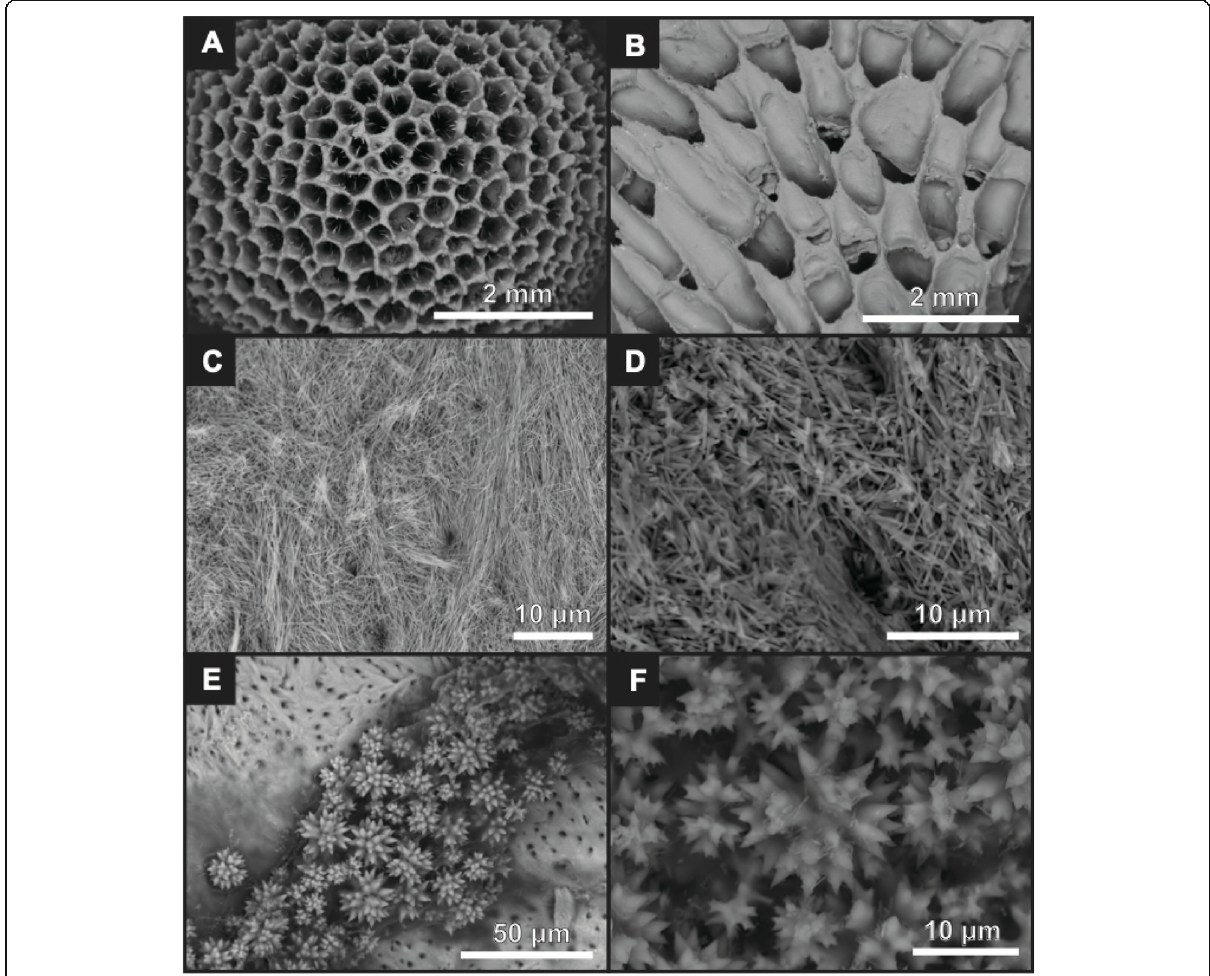
Fig. 3 Scanning electron micrograph images of sclerosponges. A well-preserved pristine calcite skeleton is visible. A and B Macrostructural organization of high-Mg calcite skeleton with vertical calicles subdivided by horizontal tabulae. C and D Lamellar microstructure of high-Mg calcite skeleton, the secondary structure of the tabulae and coatings of the tubes, randomly oriented single crystals. E and F Spicular skeleton and spiraster